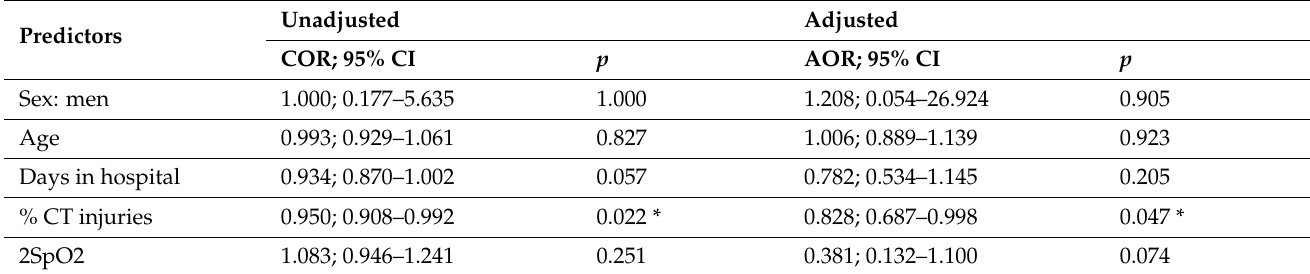
Table 5. Characteristics of the association of predictors with the IFN-α2b treatment.